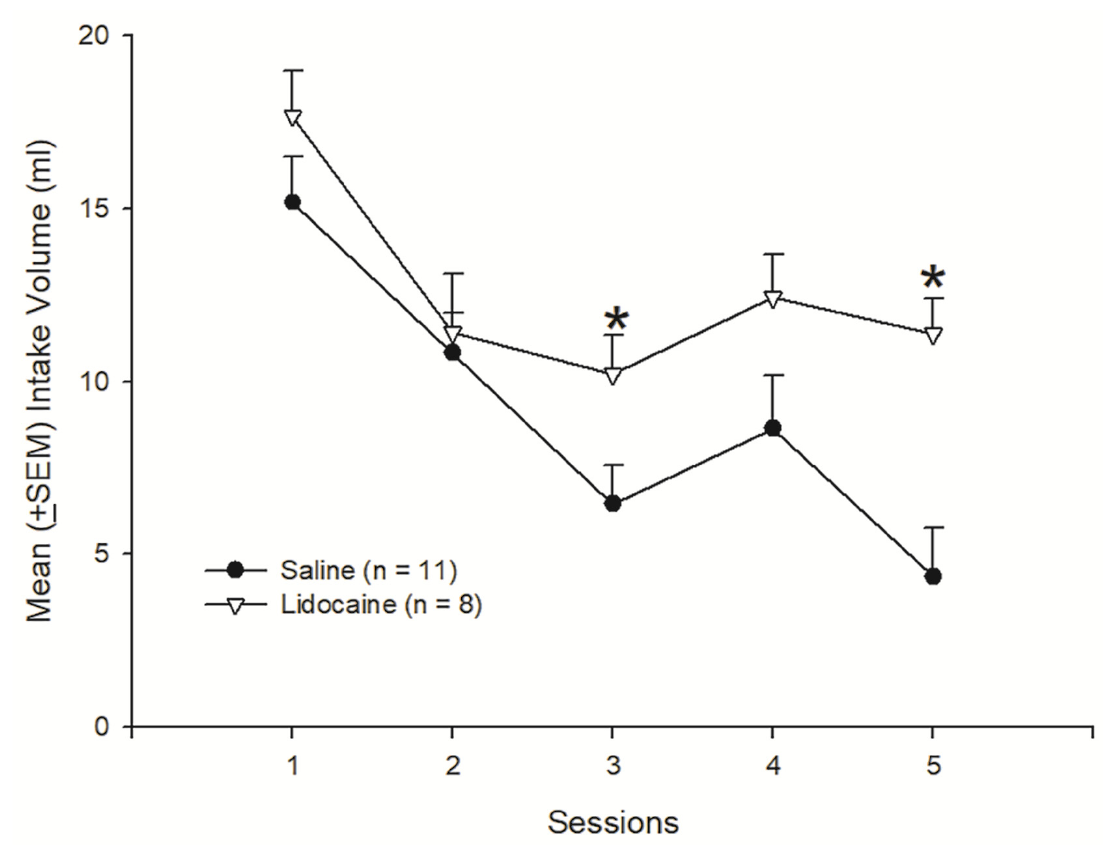
Figure 3. Mean ( ± SEM) intake volume (mL) of 0.1% saccharin solution for the Saline ( n = 11) and Lidocaine ( n = 8) groups. All rats were allowed to freely drink a 0.1 % saccharin solution for 15 min and then received microinjections of the basolateral amygdala with normal saline or 4% lidocaine. Later, rats were given an intraperitoneal injection of a 0.15M LiCl solution. The procedure was one day for a session over 5 sessions. * p < 0.05 compared with the Saline group.